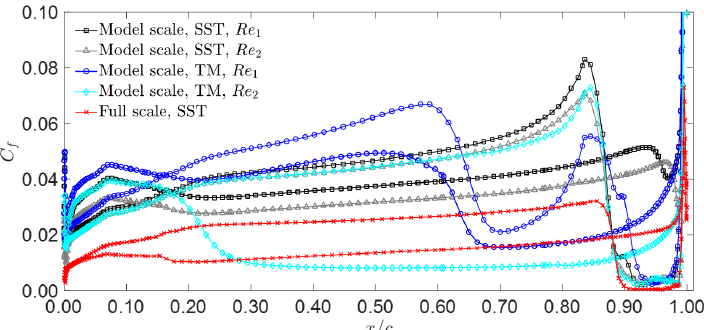
Figure 31. Comparison of skin-friction coefficients at the radius r / R = 0.7 on the blades. PPTC Case 1 conditions in model- and